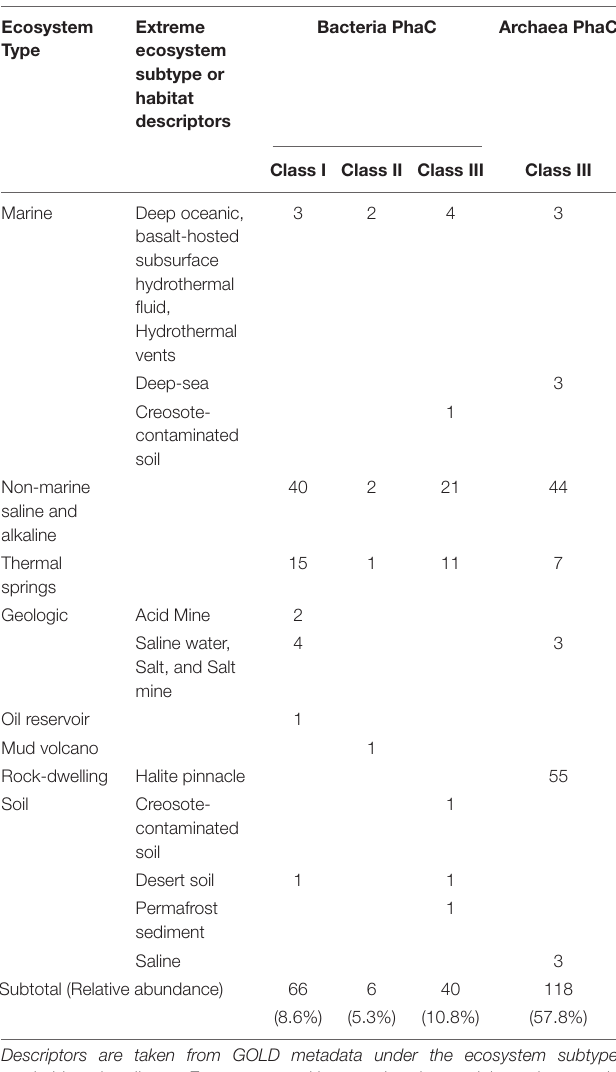
TABLE 1 | Environmental PhaC genotypes found in extreme physicochemical